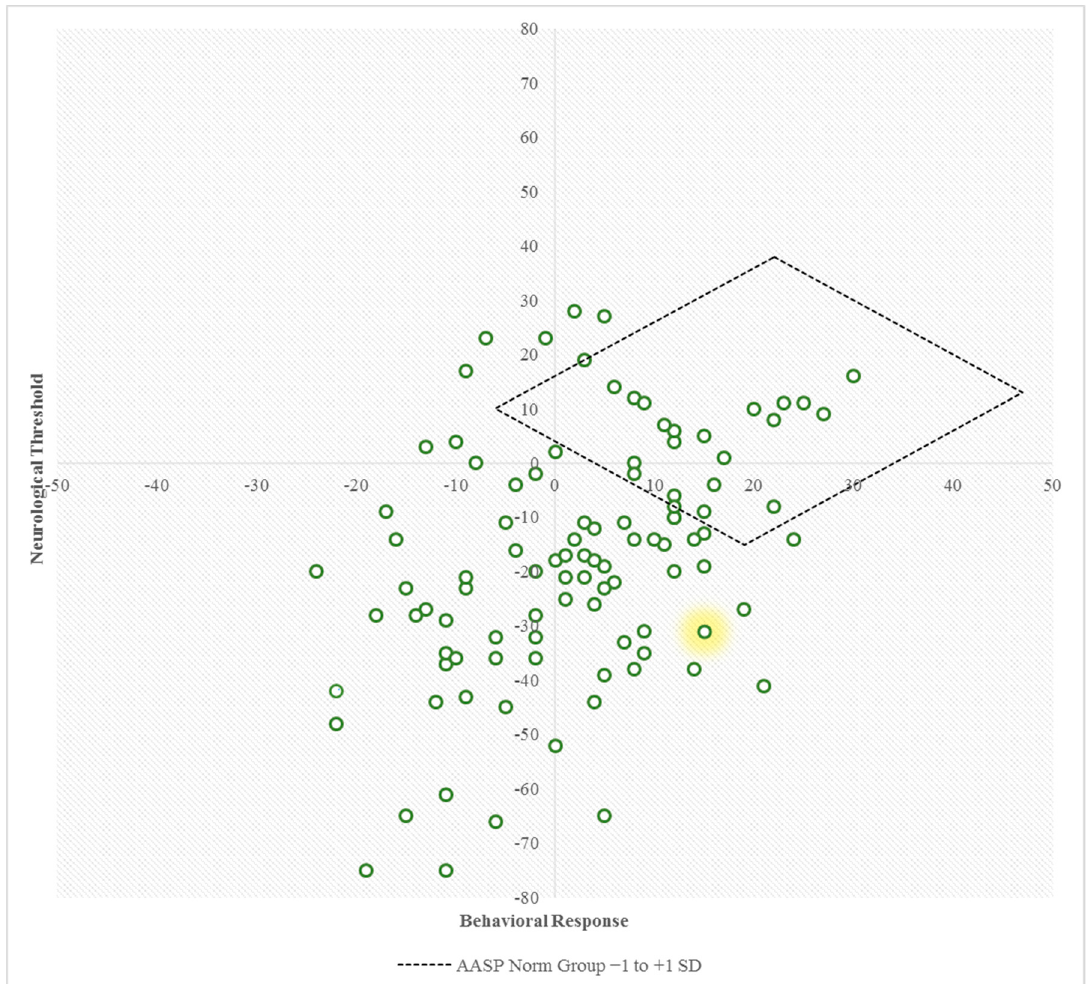
Figure 2. Scatterplot based on the calculated neurological threshold and behavioral response scores. The diamond shaped region represents the norm group’s neurological threshold scores and behavioral scores, as calculated with the norm group’s four quadrant score ranges between − 1 and +1 SD. The highlighted data point represents patient Z from the example presented.